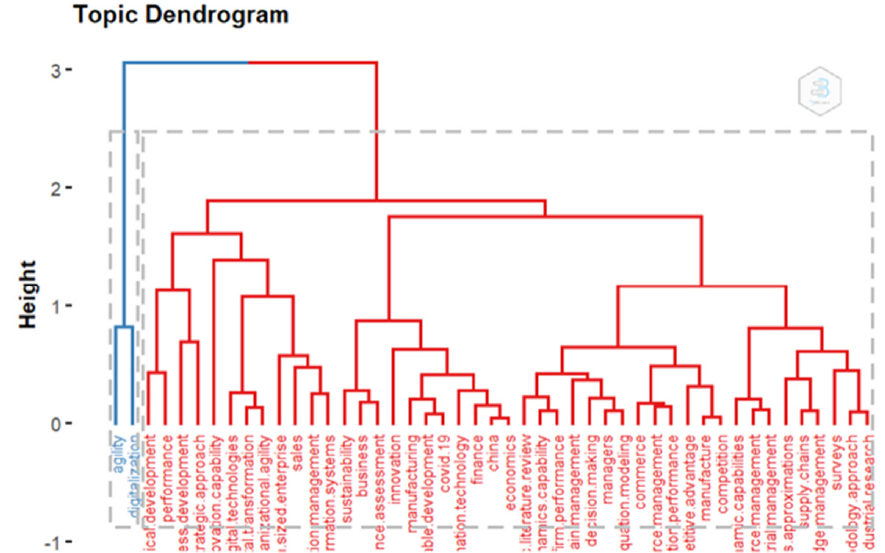
Figure 8. Factorial analysis based on MCA method. Source: Scopus/Biblioshiny.